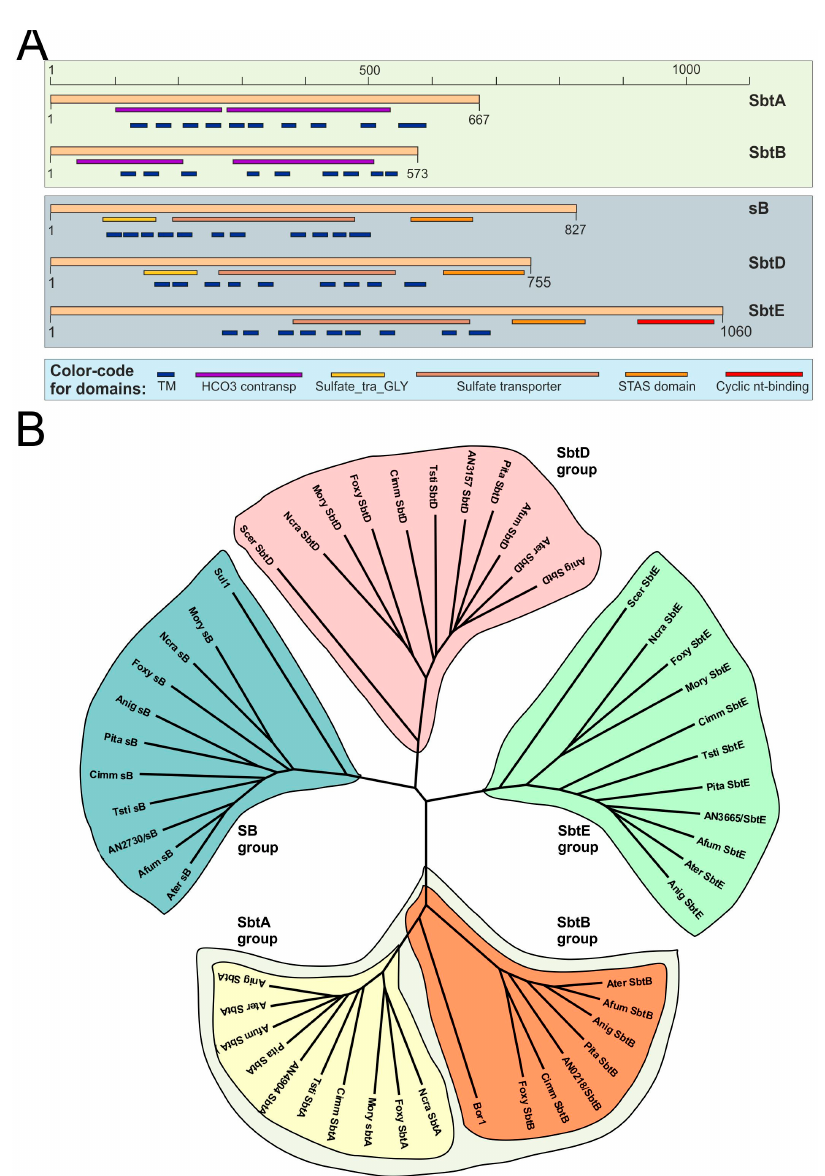
Figure 3. Phylogenetic analysis of A. nidulans Sbt proteins. ( A ) Domain organization of SbtA, SbtB, SB, SbtD and SbtE. The position and extension of predictably functional domains is indicated according to the information provided by the AspGD database. Nomenclature: Tm, transmembrane domain; HCO 3 cotransp, bicarbonate transporter domain (IPRO11531); Sulfate_tra_GLY, sulfate transporter N-terminal domain with GLY motif (PF13792.1); Sulfate transporter, SLC26A/SulP transporter domain (IPRO11547); STAS, sulfate transporter and antisigma factor antagonist domain (IPRO02645); Cyclic nt-binding, cyclic nucleotide-binding domain (IPRO00595). This database did not predict the presence of an intron within the third exon of sbtB , which is spliced according to our RNA-seq results (see also Figure S1) [17,18]. This intron corresponds to a region of 21 amino acids between positions 253 and 274 of the protein sequence predicted by the AspGD. This region was not present in orthologs of SbtB and was, consequently, not considered for evolutionary analyses. ( B ) Phylogenetic tree for the ortholog groups of Sbt-s. While groups of SB, SbtD and SbtE are clearly differentiated, the conservation among SbtA and SbtB orthologs is higher (not shown) and the evolutionary distance lower. MEGA software (version 4) was used [20]. Nomenclature: An: A. nidulans ; Afum: Aspergillus fumigatus ; Anig: Aspergillus niger ; Ater: Aspergillus terreus ; Pita: Penicillium italicum ; Cimm: Coccidioides immitis ; Tsti: Talaromyces stipitatus ; Ncra: Neurospora crassa ; Foxy: Fusarium oxysporum ; Mory: Magnaporthe oryzae ; Scer: Saccharomyces cerevisiae .